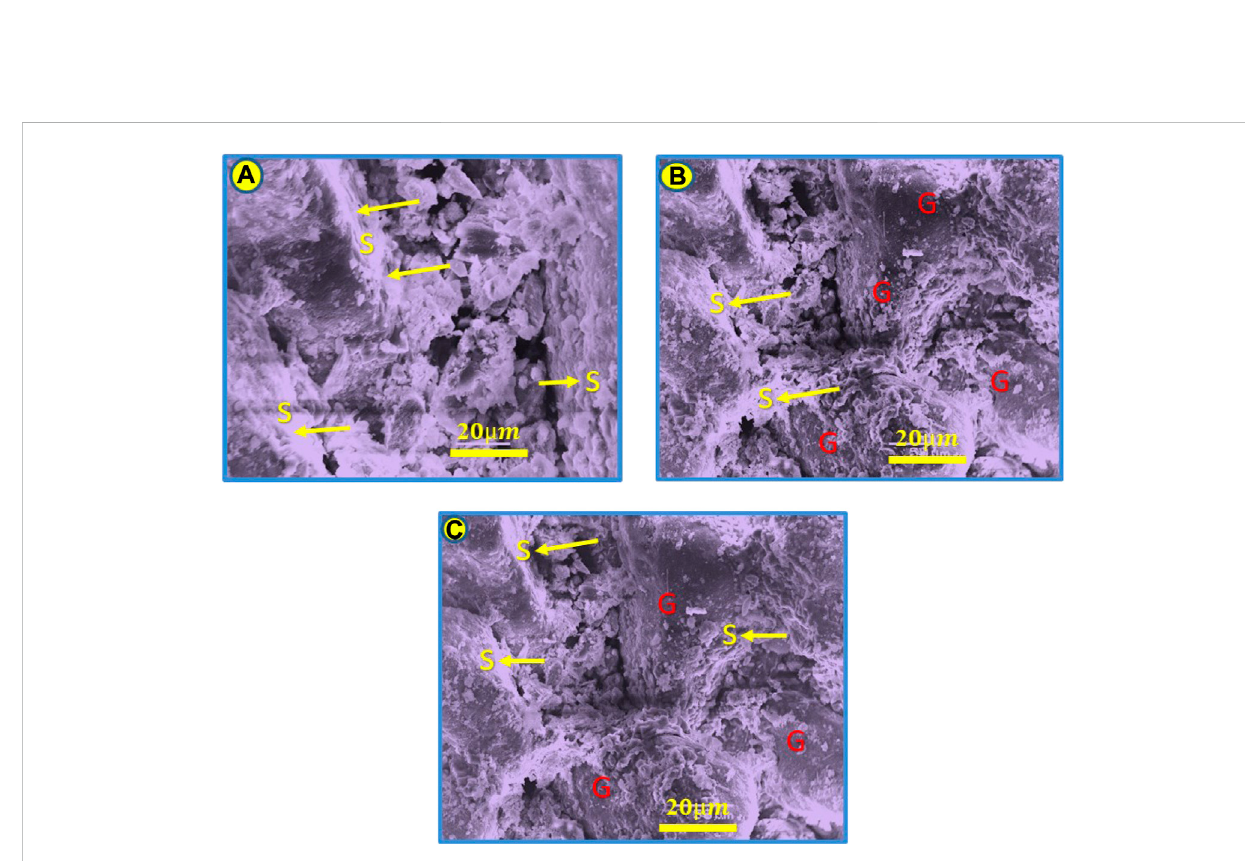
FIGURE 12 SEM images (400x): (A) 5% NaCl, (B) 10% NaCl, and (C) 20% NaCl. (For legend, G = grain of soil, S = salt “ NaCl ” ).